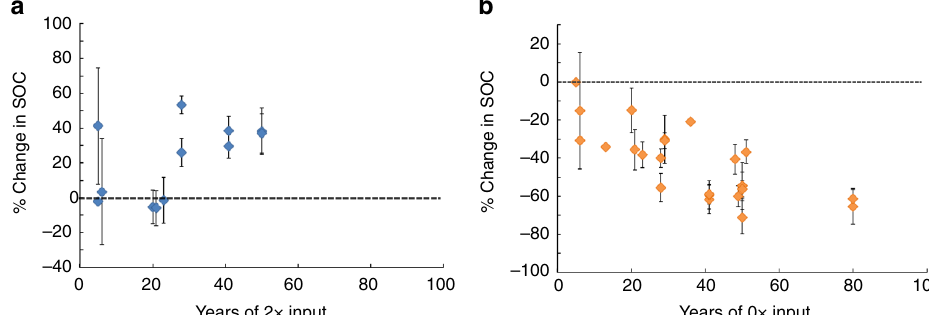
Fig. 6 Response of SOC to doubling and removal of C inputs in long-term litter manipulations. a Percent change in SOC at Detritus Input and Removal Treatment (DIRT) experiments after a sustained 2× step increase in inputs. b Percent change in SOC at DIRT and Long-Term Bare Fallow (LTBF) experiments after sustained 0× inputs. Points indicate means and bars the s.e.m. Individual points are separated by site in Supplementary Fig. 10 and data sources are reported in Supplementary Tables 2 and